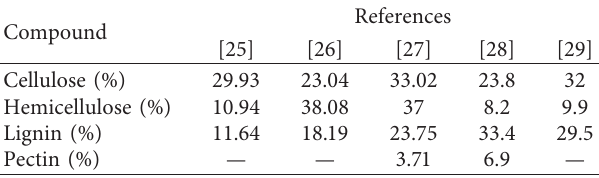
Table 2: Lignocellulose and pectin content in CPH.